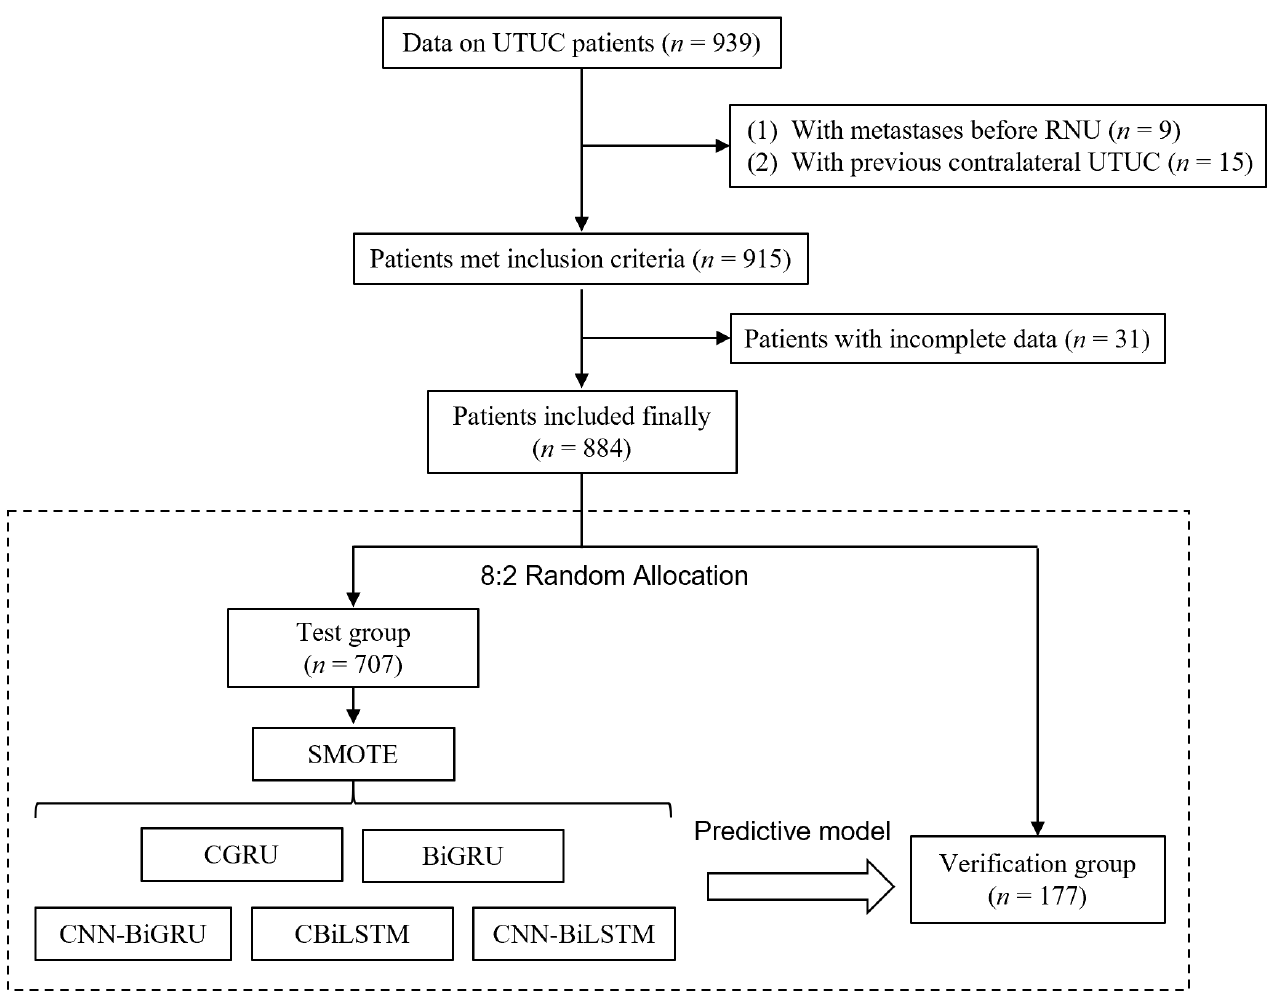
Figure 1. Flowchart of the study. UTUC, upper tract urothelial carcinoma; RNU, radical Figure 1. Flowchartofthestudy. UTUC,uppertracturothelialcarcinoma; nephroureterectomy.